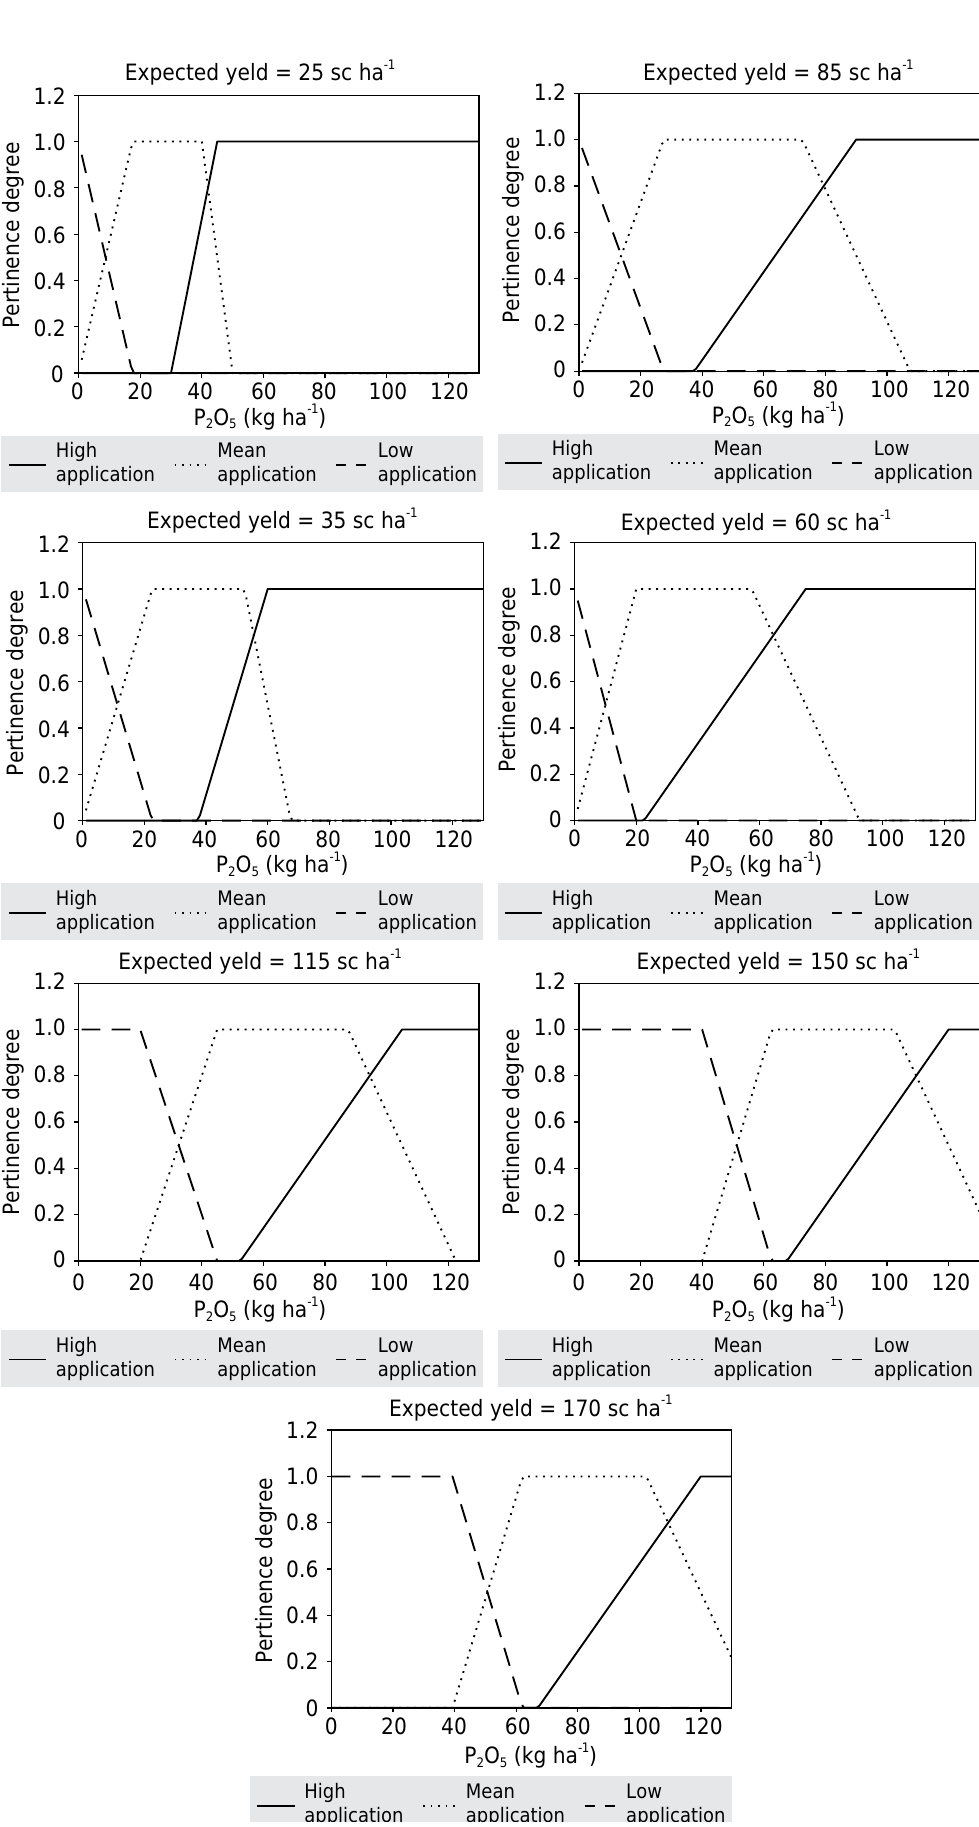
Figure 7. Fuzzy sets for the input variable of phosphorus application need